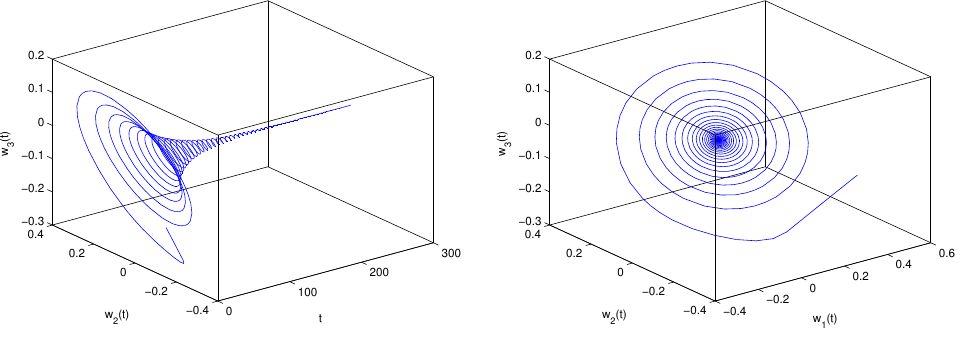
Figure 1. Computer simulation figures of system (95) with ρ = 0.5 < ρ 0 ≈ 0.6. The three variables